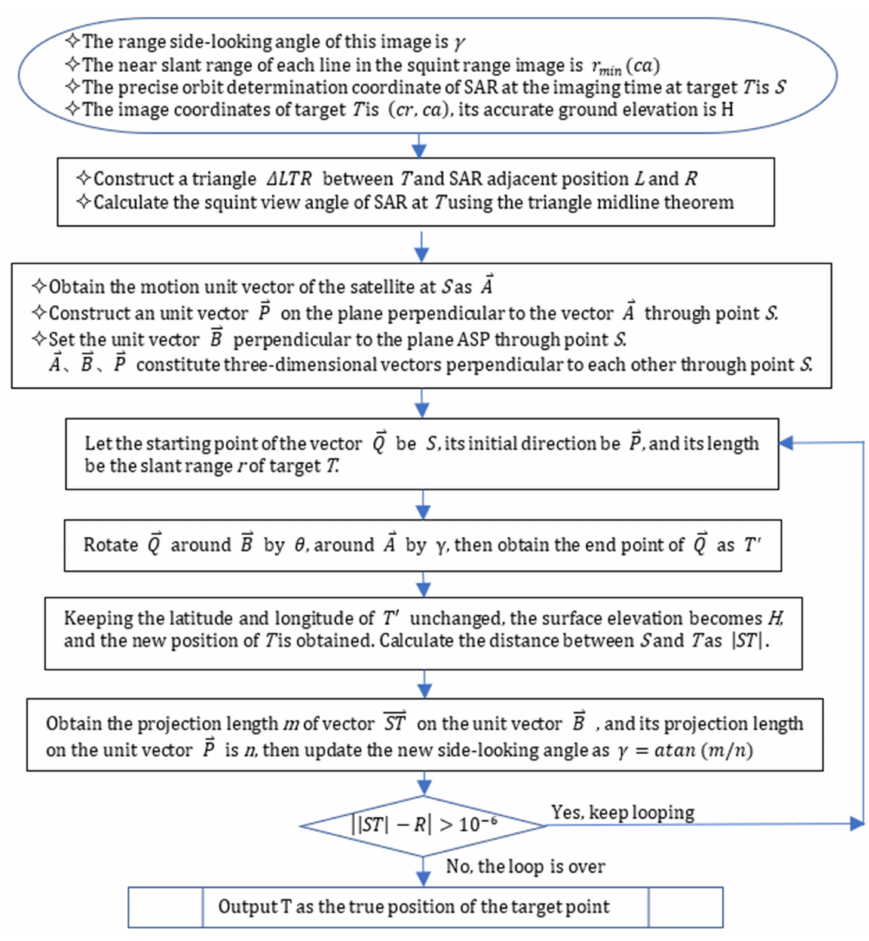
Figure 9. Forward geometric positioning flow for squint sliding-spot imaging